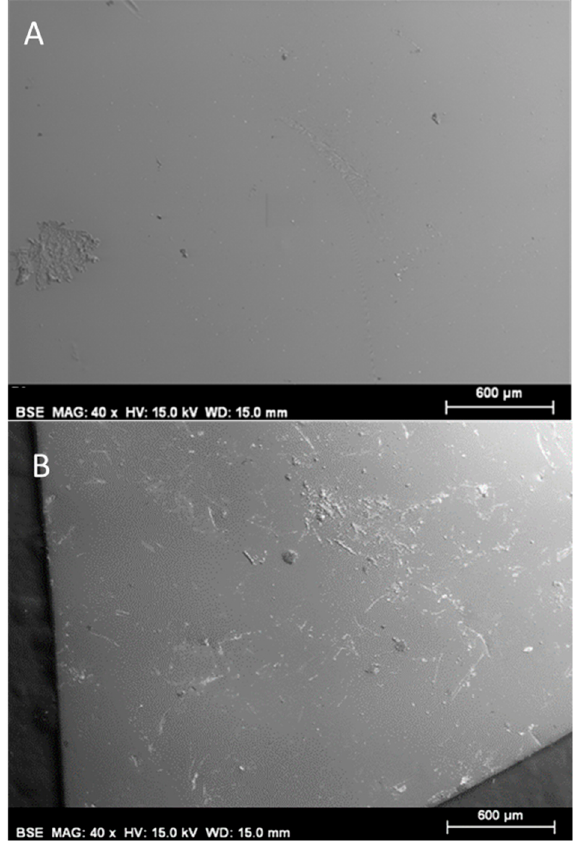
Figure 2. Scanning electron micrograph of the membrane with [MTOA + ][Cl − ] ionic liquid after being used in MFC with white oil refinery industry wastewater.